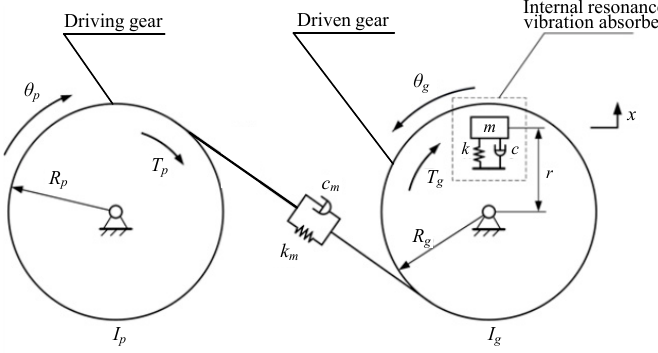
Figure 1. Gear model with an internal resonance vibration absorber. The internal resonance vibration absorber is a vibration subsystem composed of three parts: a mass unit m , a stiffness unit k , and a damping unit c that dissipates energy. The vibration absorber moves linearly along the radial direction of the driven gear. Its generalized coordinate is x , which represents the distance of the vibration absorber’s mass unit relative to the equilibrium position; r represents the distance between the equilibrium position and the center of the driven gear.